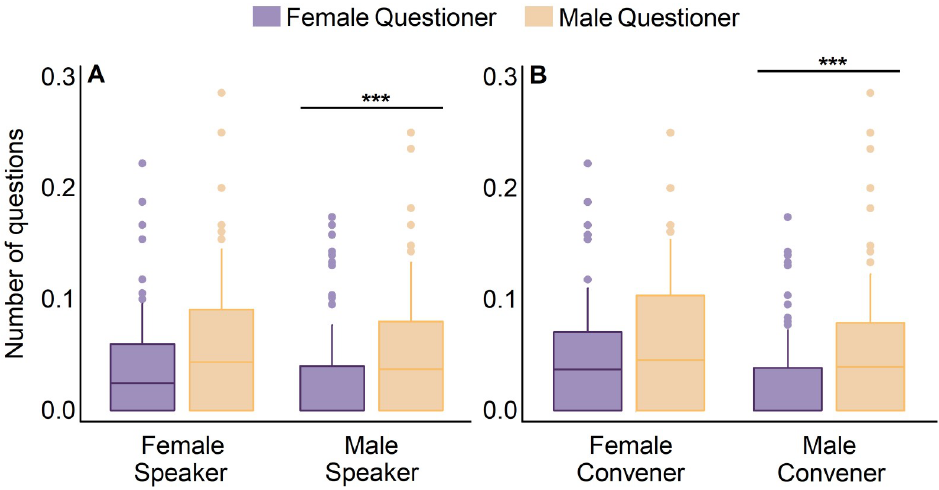
Fig 4. Number of questions per talk raised by women (purple) and men (yellow) considering the gender of (A) the speaker and (B) the convener. In all cases, the number of questions raised by each gender is standardized by the number of attendees of that gender (i.e., number of questions made by women / number of women in the audience). Asterisks indicate significant differences between the number of questions asked by women and men (t-test, p < 0.05).